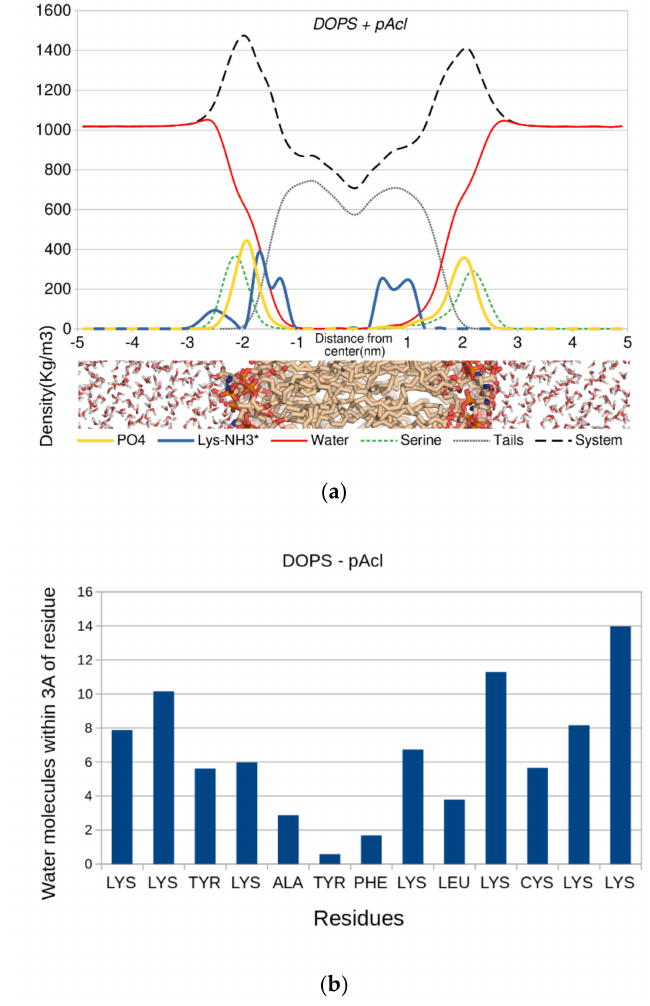
Figure 6. Density of the main constituents of the system as a function of the bilayer normal. Top ( a ): the center of the bilayer is located at z = 0. Bottom ( b ): the number of water molecules whose oxygen atom is within 3.0 Å of any heteroatom of the p-Acl